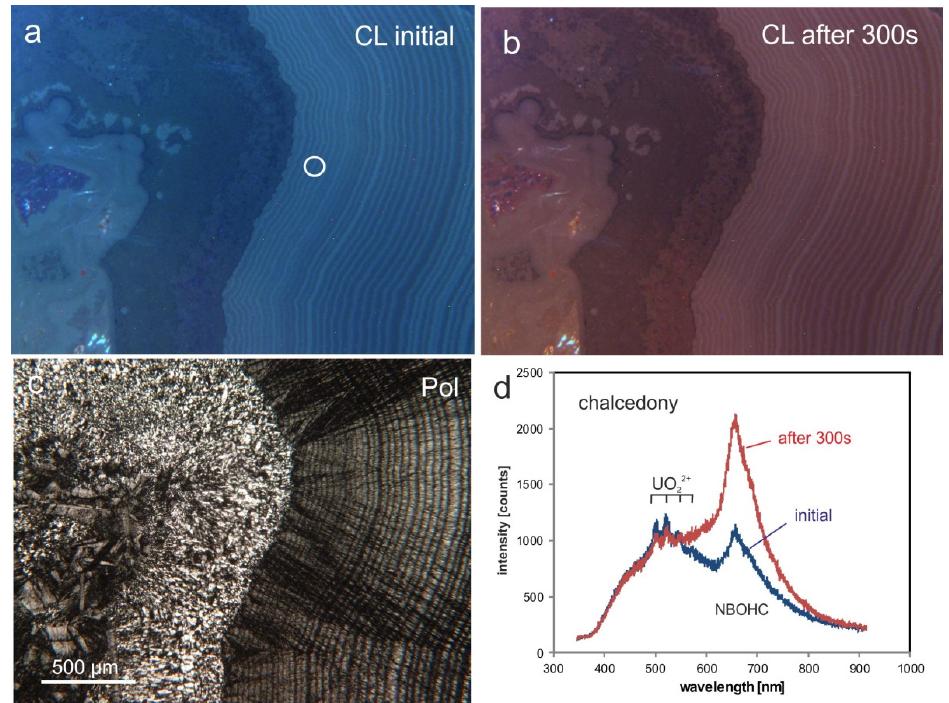
Figure 10. Micrographs of agate ACu2 showing the initial CL ( a ) compared with the CL after 300 s electron irradiation ( b ) and the sample area in transmitted light (crossed polars) ( c ) as well as the related CL spectra, which are dominated by a strong emission band centered at ca. 650 nm due to the non-bridging oxygen hole center (NBOHC) and multiple emission lines of the uranyl ion ( d ). The circle in ( a ) marks the position of the spectral CL measurement.